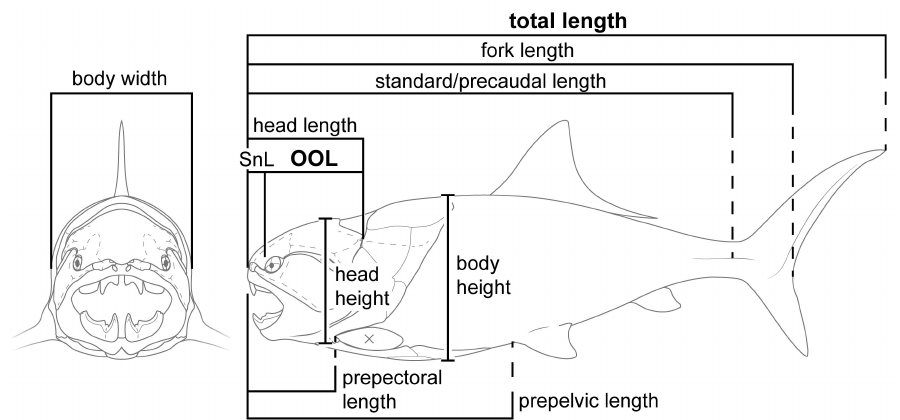
Figure 4. Reconstruction of a juvenile Dunkleosteus terrelli , showing the measurements used in this study. Abbreviations: SnL, snout length; OOL, orbit-opercular